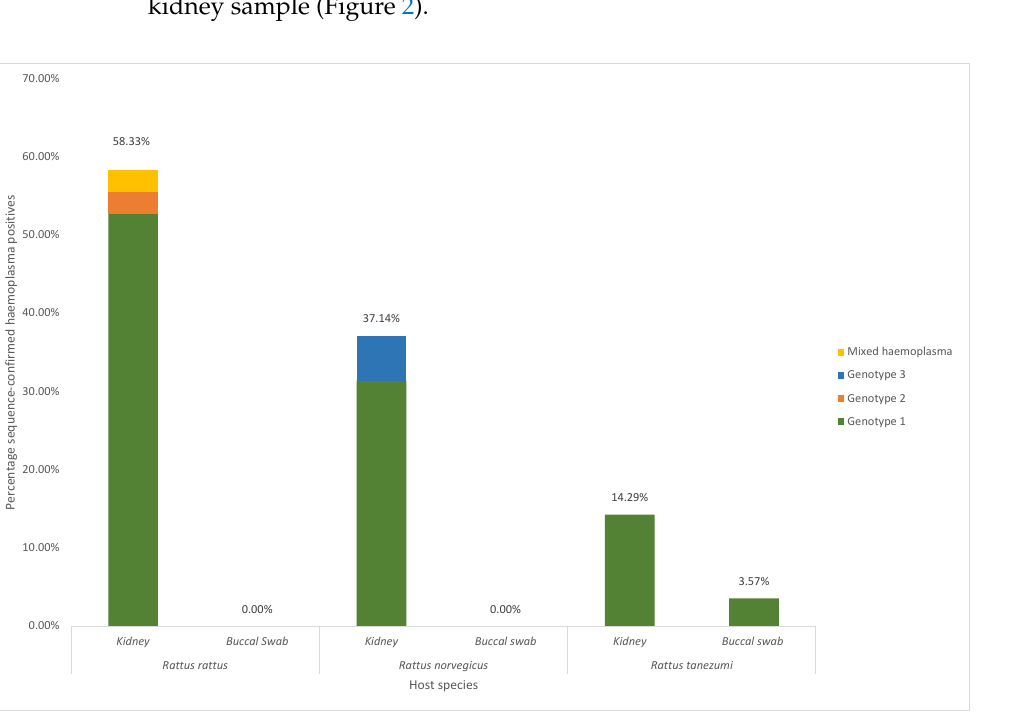
Figure 2. Percentage of sequence-confirmed haemoplasma positive samples detected in kidney and buccal swabs of 99 Rattus individuals, comprising of three species ( Rattus rattus , R. norvegicus, and R. tanesumi ) assessed in this study. In total, three different haemoplasma genotypes and one mixed haemoplasma sequence were detected in the Rattus samples screened. Genotype prevalence per tissue type and per Rattus species are